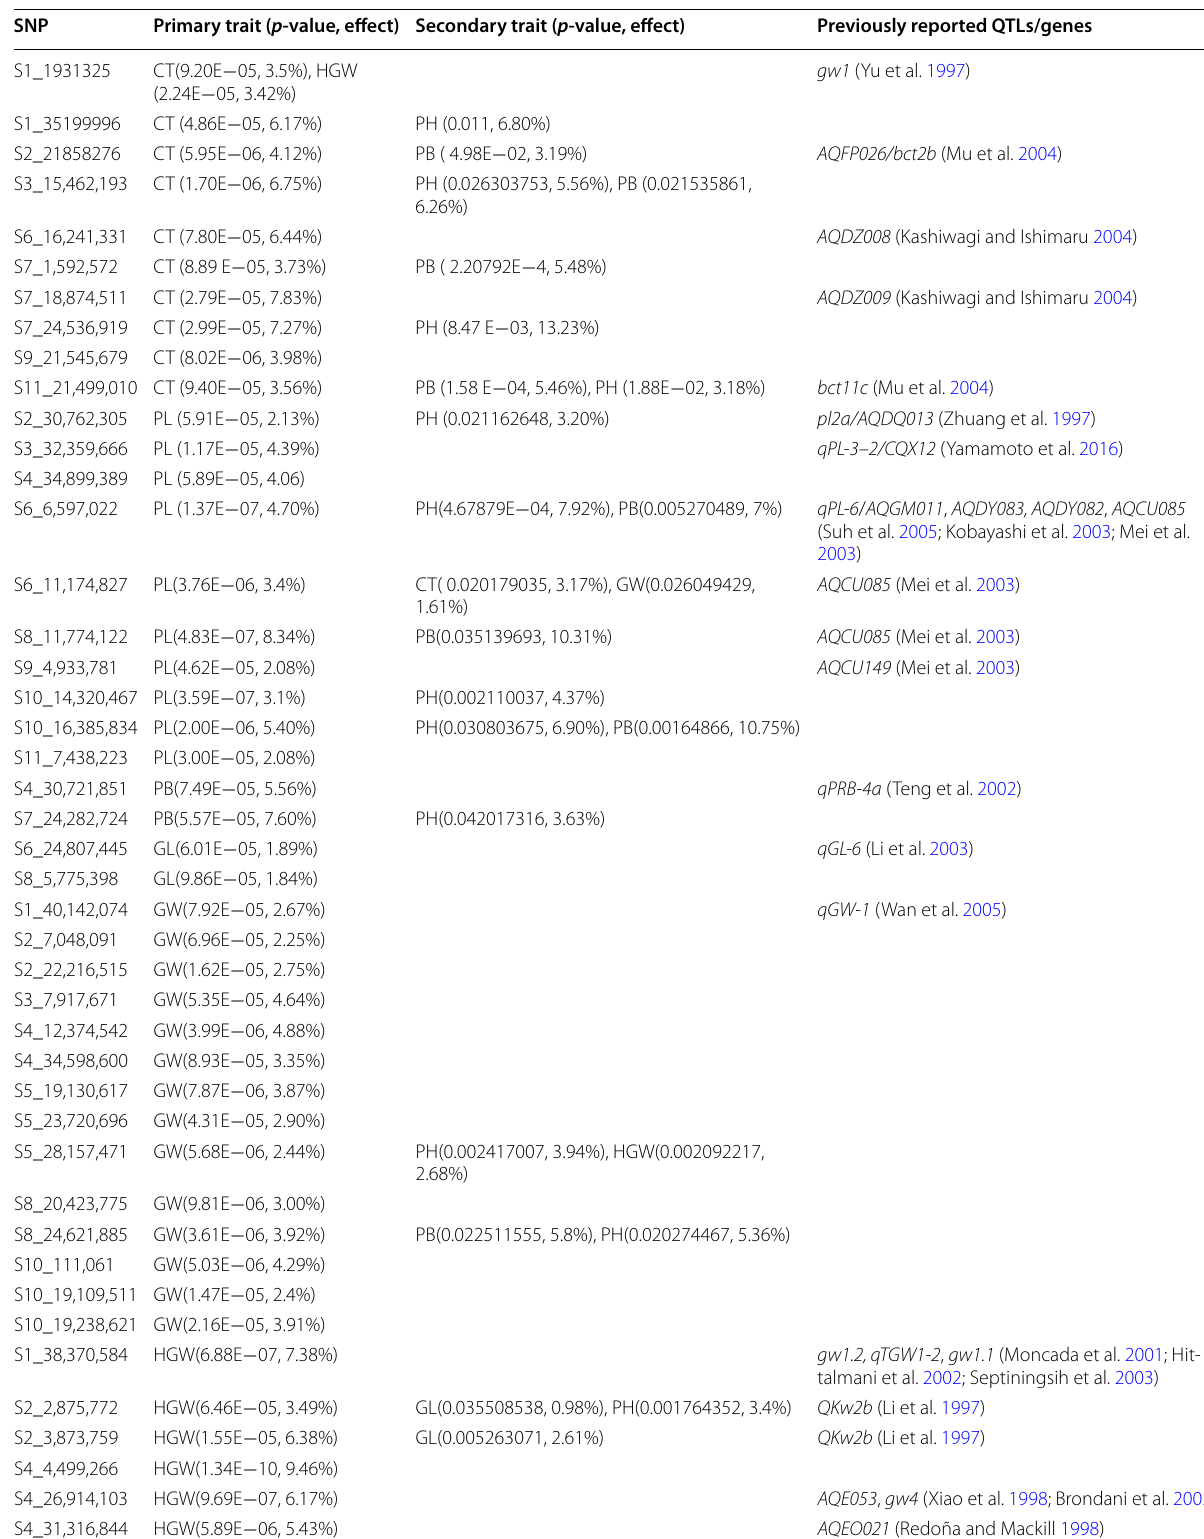
Table 3 MTAs identified through GWAS for seven productivity related traits in AM panel of 346 O. rufipogon accessions